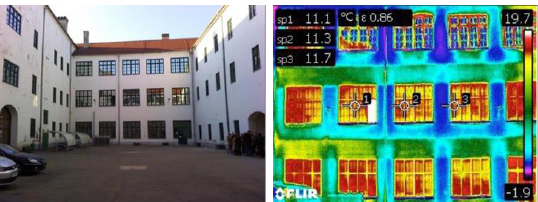
Figure 4: Using thermal imagery to identify the structure system, different materials and thermal bridges. (Stober et al. ,